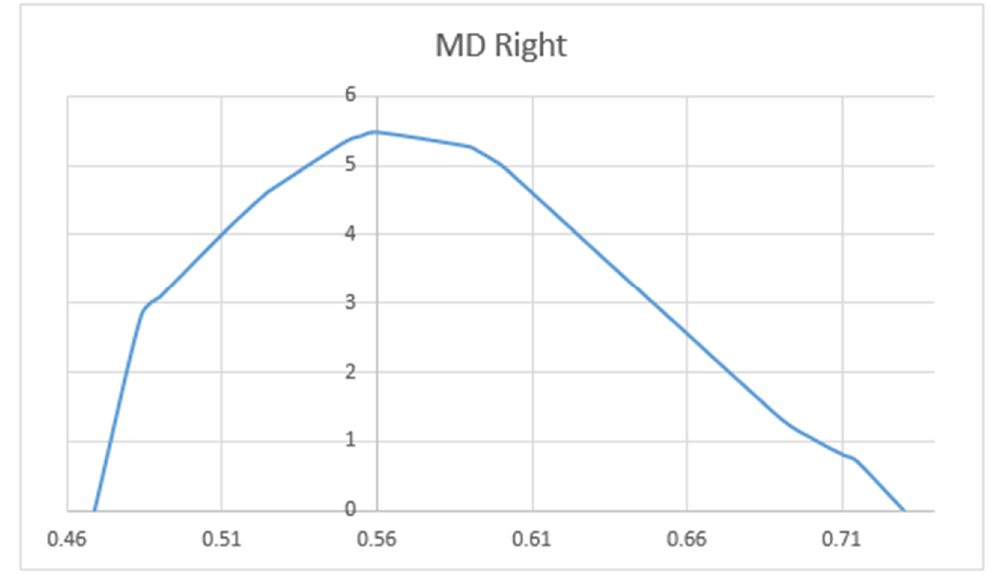
Figure 6. Distribution charts of MD in the right hemisphere of the group of 34 patients aged 25–82.